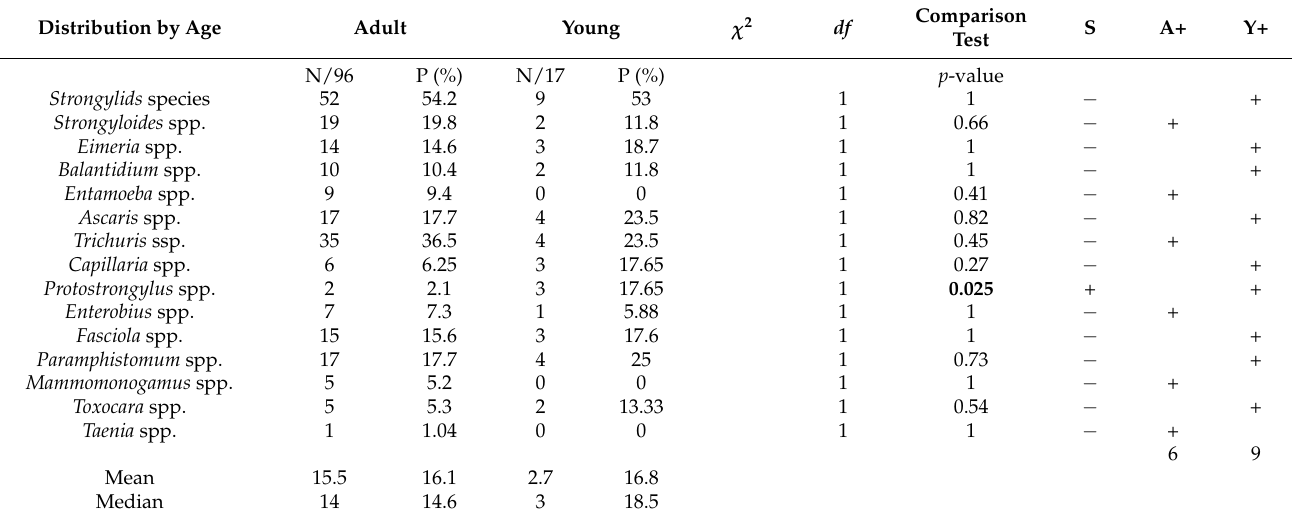
Table 5. Distribution and prevalence of parasite species reported to the age of different hosts collected during the study